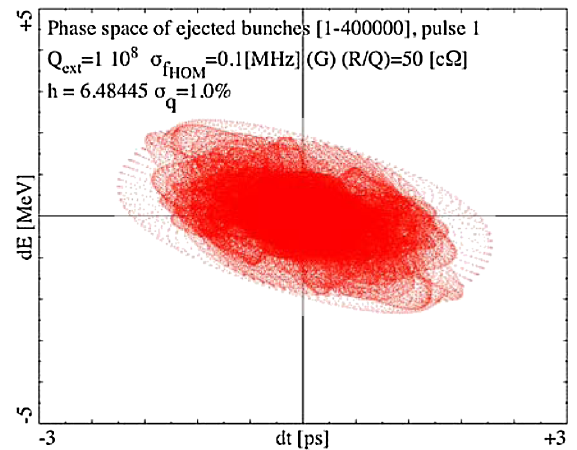
cavities).FIG. 8. (Color) Phase space as Fig. 6, Fig. 7 (identical linac, 2nd pulse): Q ext ¼ 10 8 , ð R=Q Þ ¼ 50 (cid:2) , h I b i ¼ 400 mA , (cid:1) (cid:3) f ¼ 100 kHz ; but bunch-charge jitter (Gaussian with (cid:1)